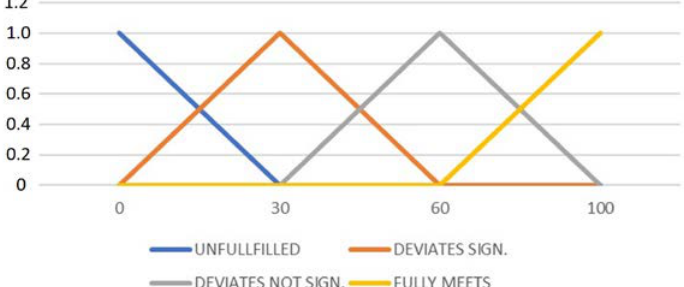
Figure 12. Graphical representation membership functions for linguistic variables for technological capabilities.